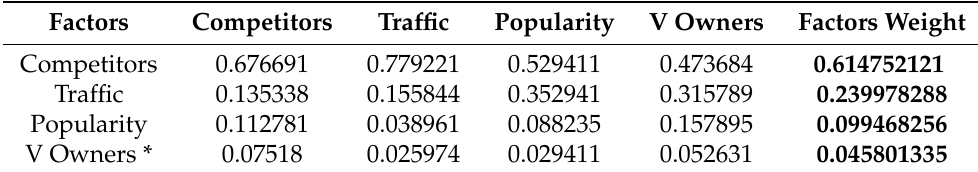
Table 4. Normalized pairwise comparison matrix with factors